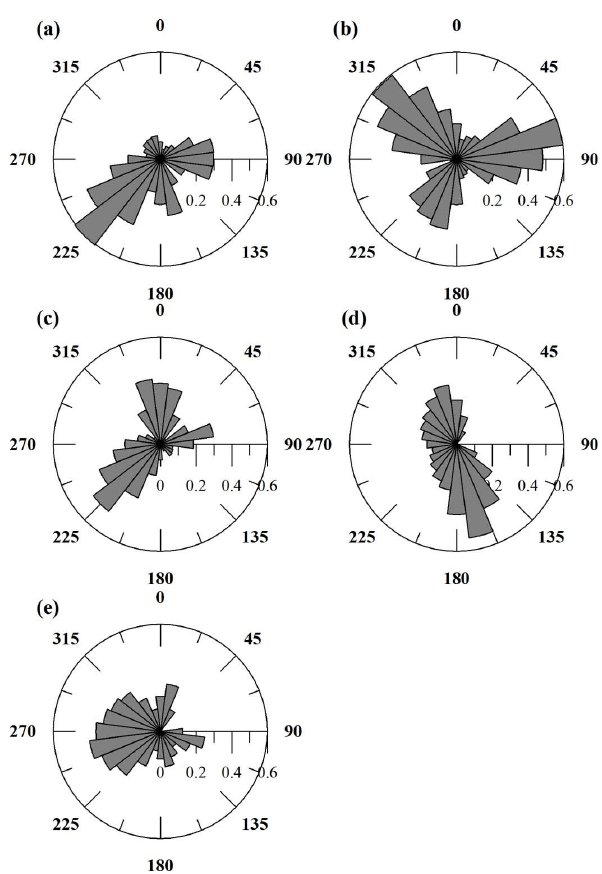
Fig. 4. CPF plots for particle number concentrations in the size range of 14nm–100nm at the five sites: Harrow (a) , Ridgetown (b) , Bear Creek (c) , Egbert (d) , and Toronto (e) . All time periods having a wind speed less than 1ms − 1 were excluded from the